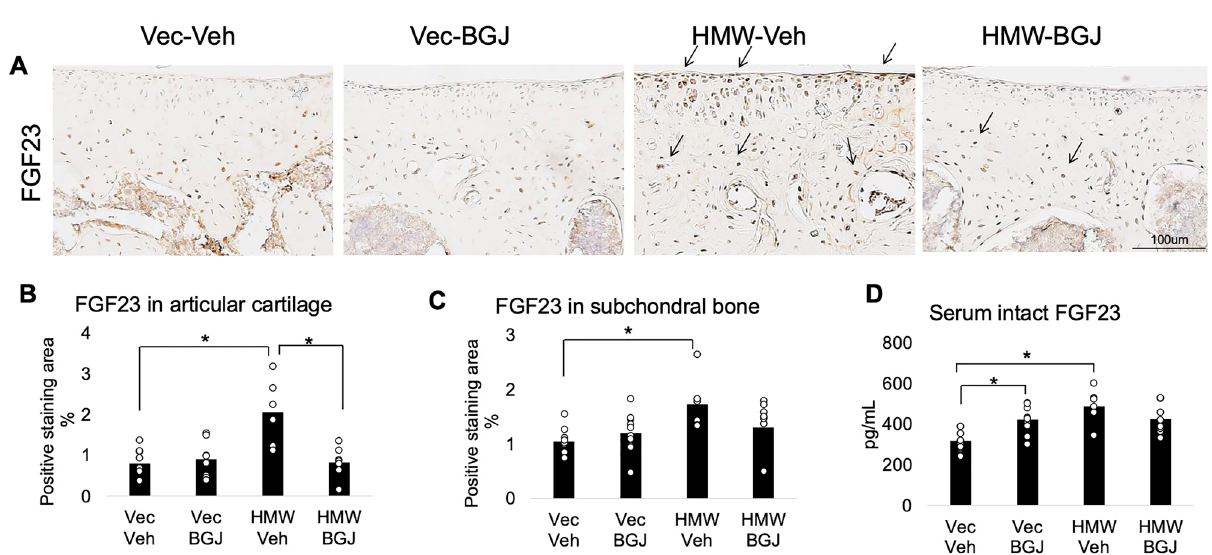
Figure 6. Expression of FGF23 in knee articular cartilage, subchondral bone and serum of 9.5-month-old Vector-Control and HMWTgFGF2 mice treated with BGJ398. Eight-month-old Vector-Control (Vec) and HMWTgFGF2 (HMW) female mice were sq injected with vehicle or BGJ398 5 days/week for 6 weeks. At the end of the experiment (9.5 months old), samples were collected. ( A ) Representative immunohistochemical staining images for FGF23. Quantitative analysis of percentage of positive staining area of FGF23 in ( B ) articular cartilage and ( C ) subchondral bone. ( D ) Serum intact FGF23 level was measured by ELISA. Data are shown as mean and individual points. n = 7–9 mice/group. *p < 0.05 by two-way